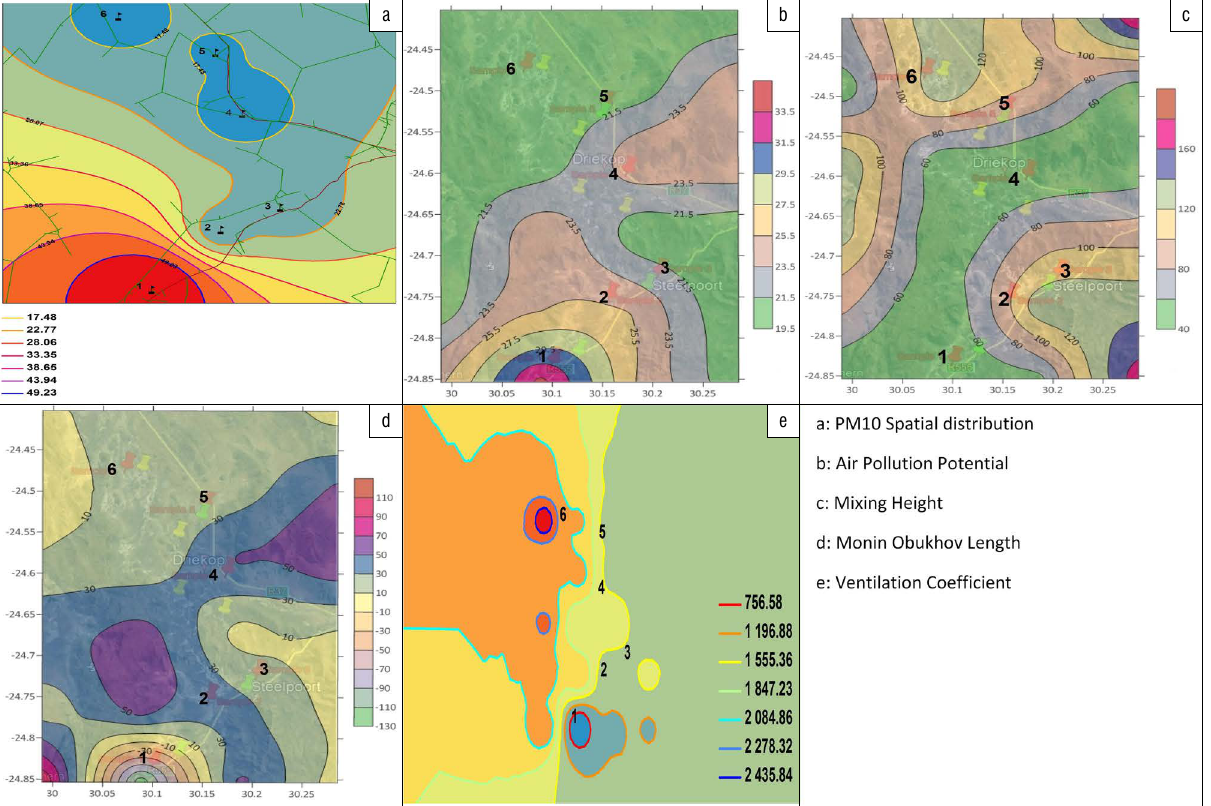
concentrations 10